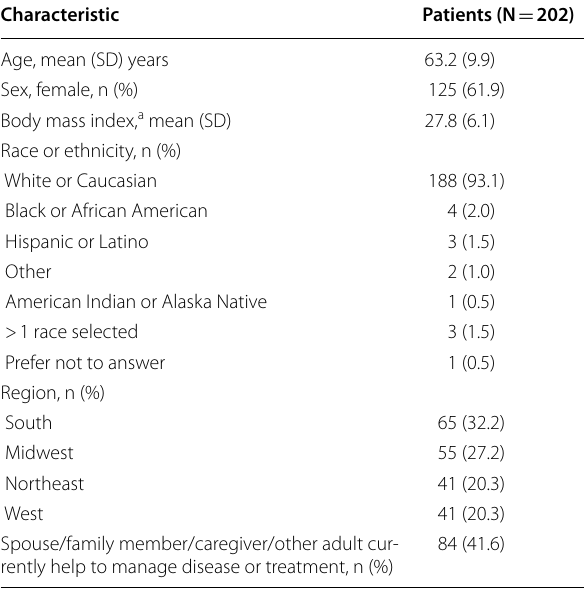
Table 1 Baseline patient characteristics (N